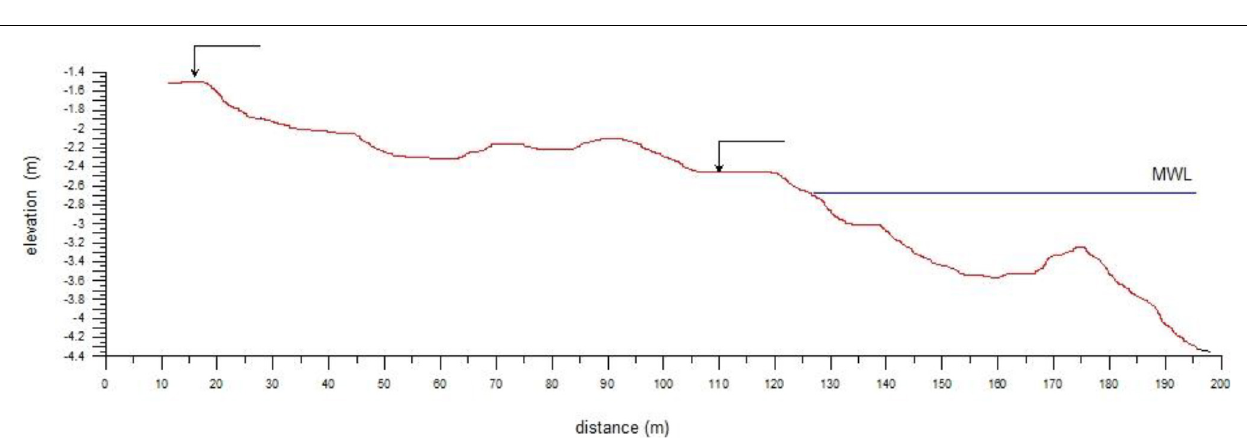
FIGURE 8 | Set of beach profiles from the Ebro delta in the Spanish Mediterranean coast, showing the standard deviation for the ensemble of surveyed profiles (vertical axis) against the profile depth (horizontal axis). The zero depth indicates the still water level shoreline, while positive depths correspond to the emerged profile and negative depths to the submerged one. The profile geometry is depicted by the inset in the upper right hand side, showing depth (vertical axis) against distance to the origin, defined from a back beach milestone.